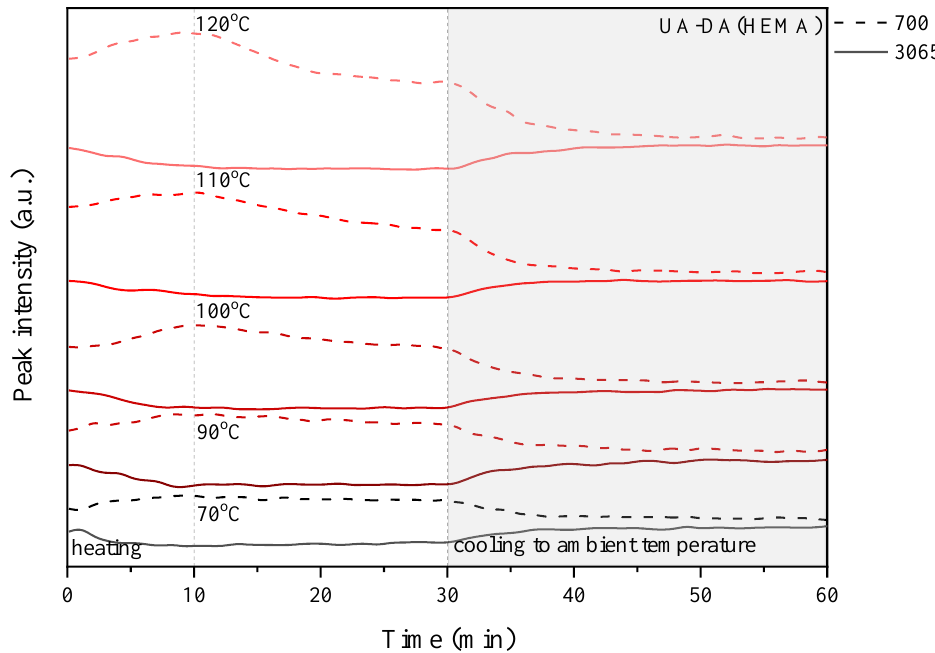
Figure 11. Change in the relative height of selected peaks based on the three-dimensional FTIR spectrum observed during the heating – thermostat – cooling cycle for the UV-cured UA-DA(HPA) sample.